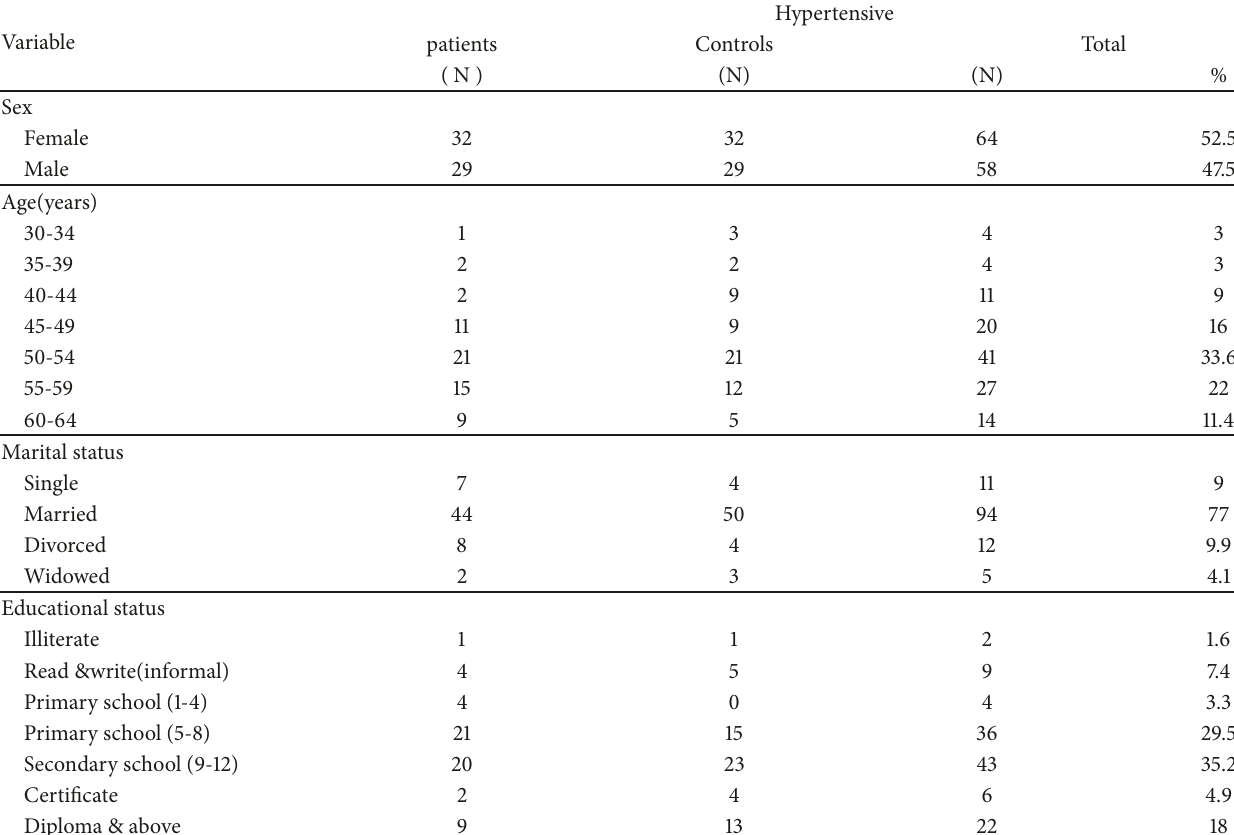
Table 1: Sociodemographic characteristics of study participants at Zewditu Memorial Hospital, Addis Ababa, Ethiopia, 2017.